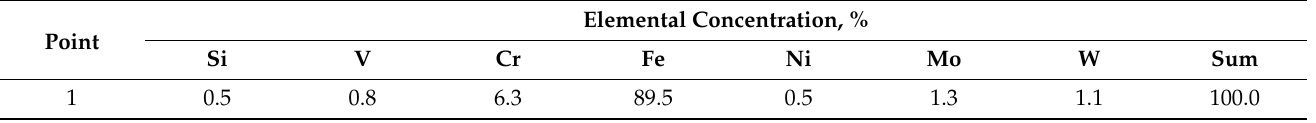
Figure 9. Qualitative analysis of the chemical composition of the W6Mo5Cr4V2 steel after dynamic alloying with SiC + Ni powder. Table 4. The quantitative analysis of channel element of the structure of W6Mo5Cr4V2 steel after the dynamic alloying in the SDP mode with SiC + Ni powder.